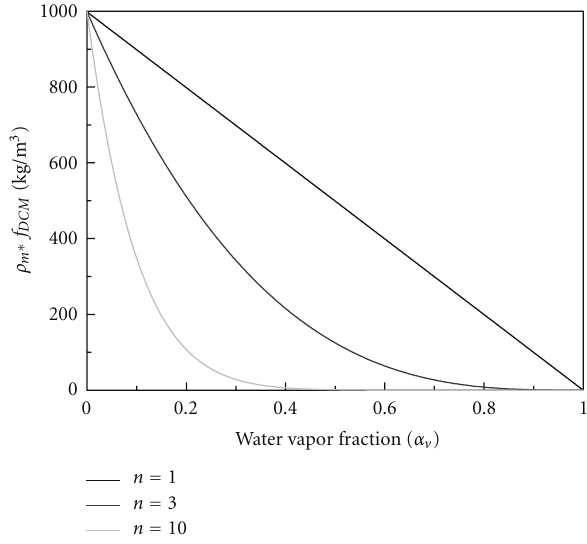
Figure 1: Local compressibility modification of the mixture density with di ff erent n values according to